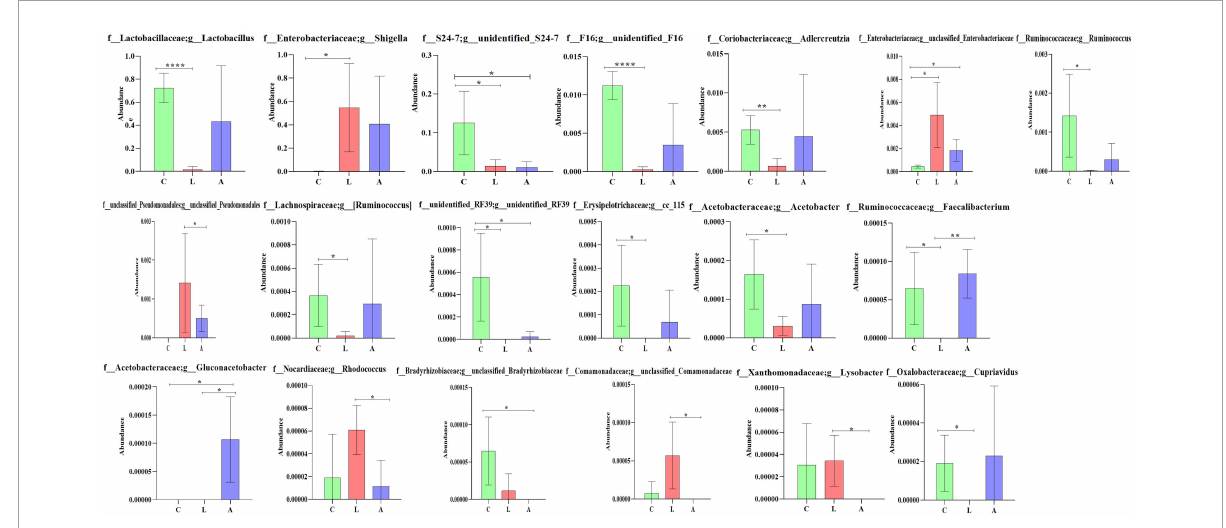
FIGURE10 Comparing genera difference of mouse microbiota. Significance is presented as ∗ p < 0.05, ∗∗ p < 0.01, ∗∗∗ p < 0.001, and ∗∗∗∗ p < 0.0001; data are presented as the mean ± SEM ( n = 4).